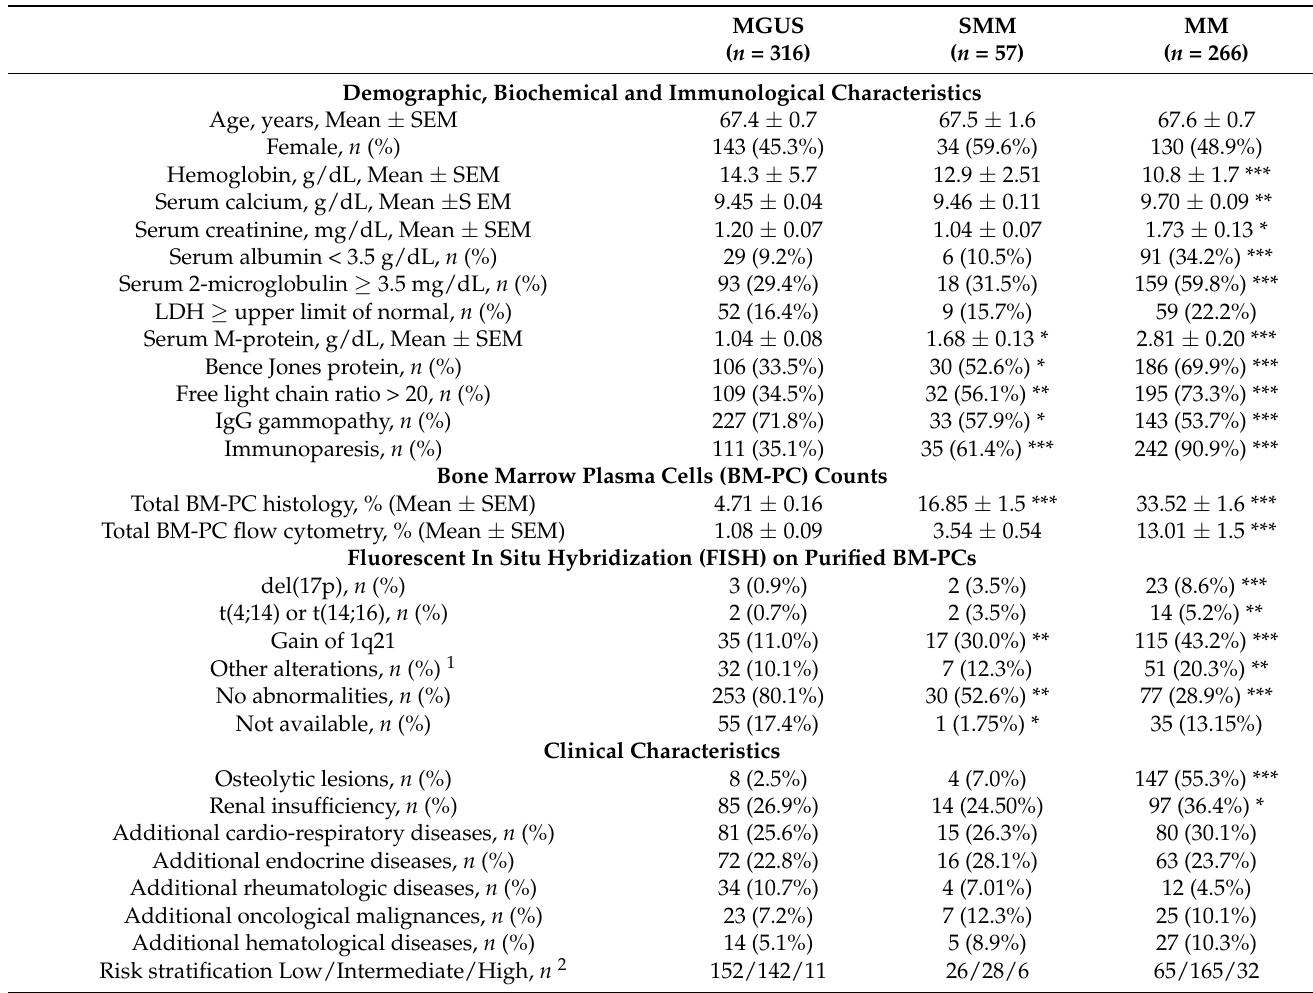
Table 1. Baseline characteristics of patients at the time of